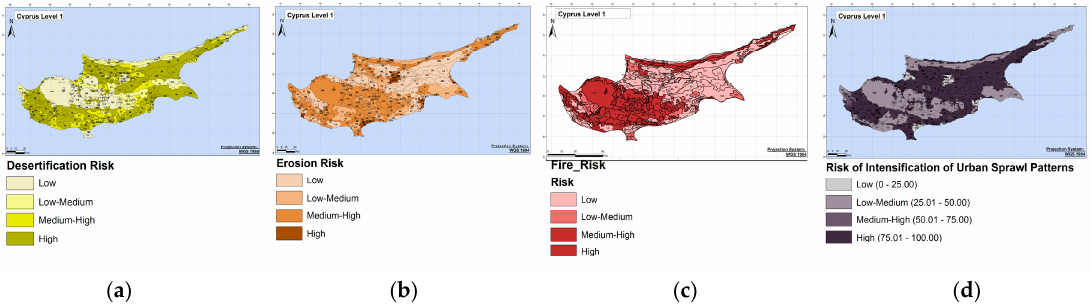
Figure 12. Hazard Maps for LDU’s of Desertification ( a ), Erosion ( b ), Forest Fire ( c ), and Intensification of urban sprawl ( d ) in Lebanon.